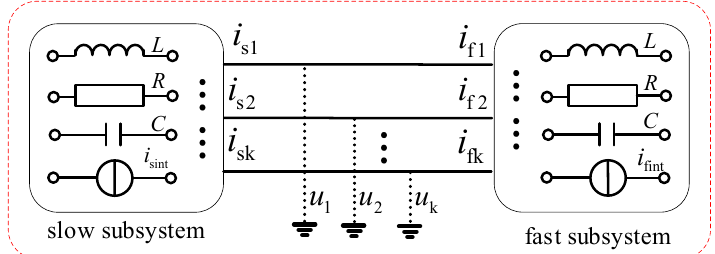
Figure 3. The diagram of the power system. The input of the slow subsystem and the fast subsystem consists of two parts, the independent current source inside the subsystem, and the voltage or current at the interface. Where i s and i f are the current vectors at the subsystem interface; u is the voltage vector at the subsystem interface; i sint and i fint are the independent current source vectors inside the subsystem. The Norton equivalent is applied to the slow subsystem and the fast subsystem, and the simulation diagram based on the Norton equivalent is as shown in Figure 4.